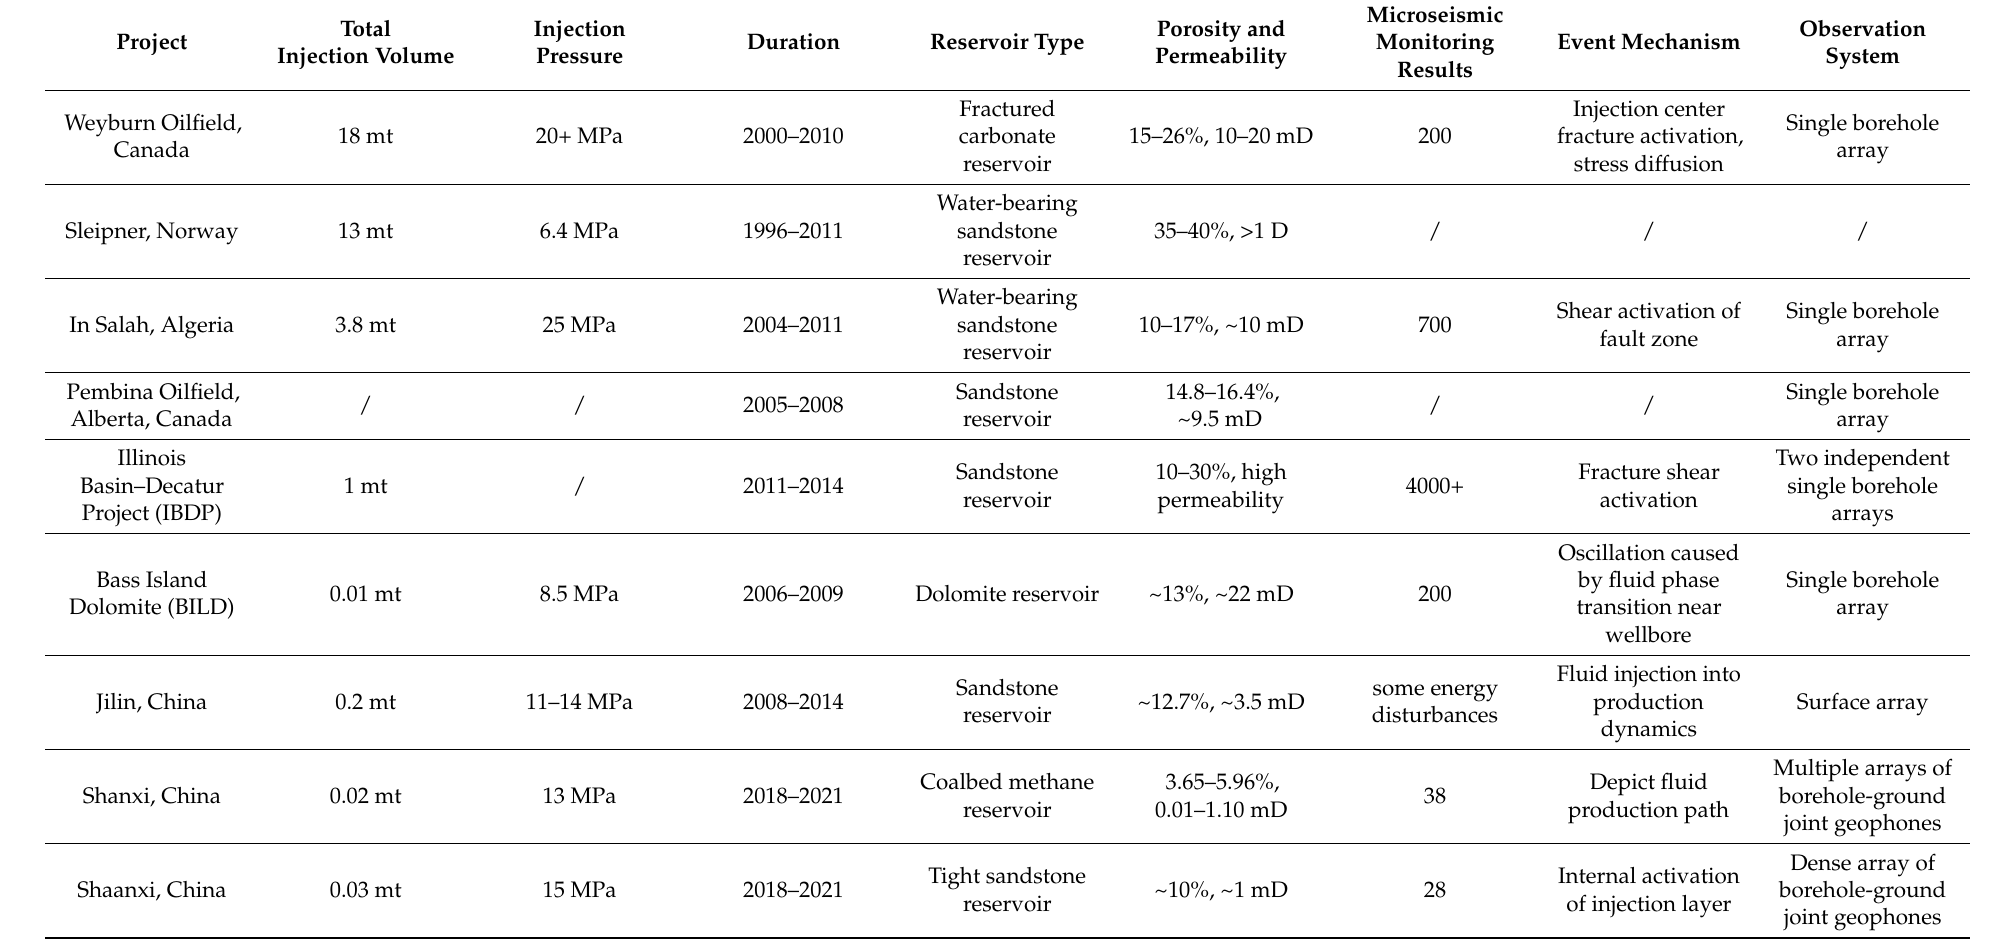
Table 1. Statistics of microseismic monitoring parameters in each work